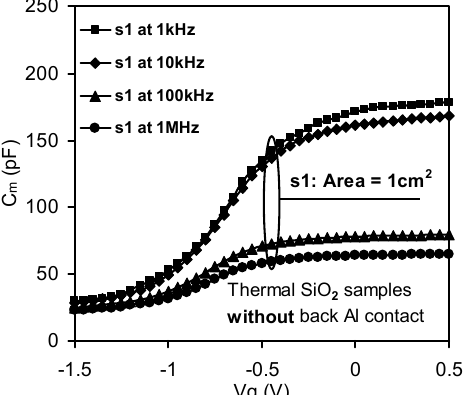
Figure 3. Frequency dispersion in C-V measurements observed in the thermal oxide (SiO sample. In the absence of a substrate back Al contact, dispersion was evident in the sample with a small substrate area of 1cm 2 [32].